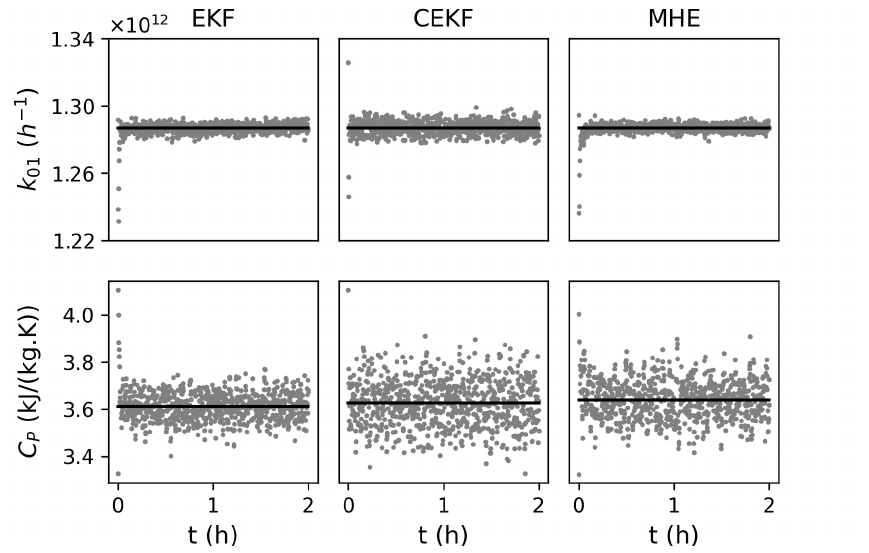
Figure 6. k 01 and C P estimations for Case 6, considering mismatch in C P